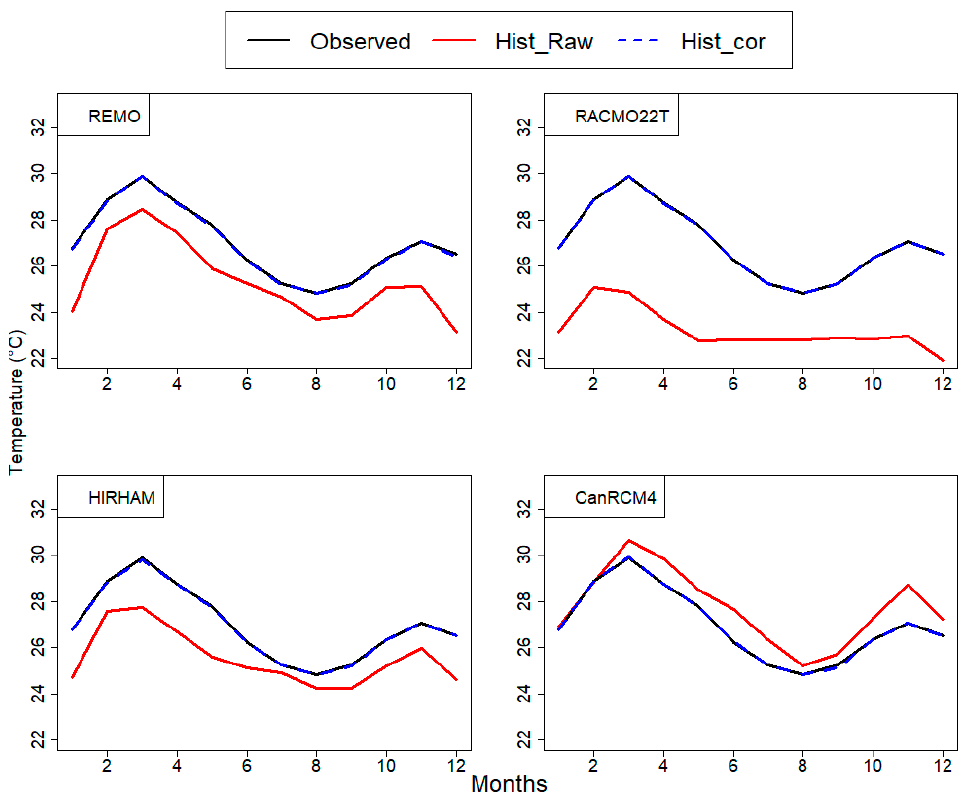
Figure 7. Comparison of raw and bias corrected temperature with observation at seasonal scale over the historical period 1971–2005.